Question: Generate an informative caption for the figure above.
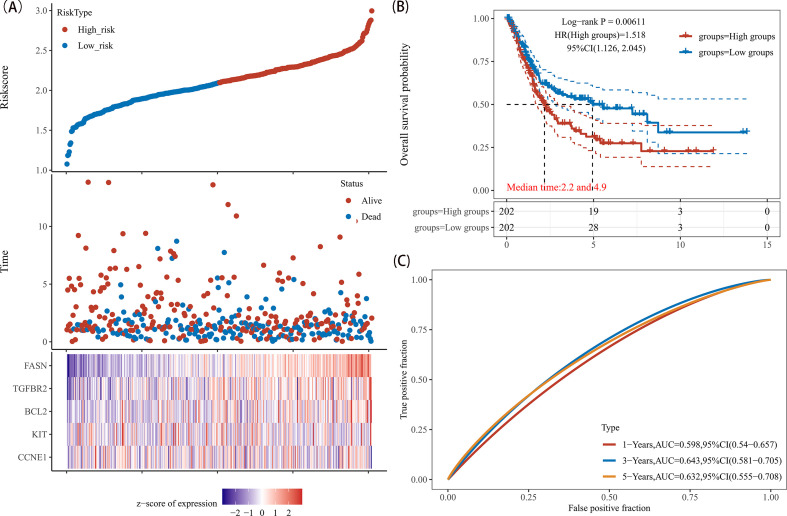
Answer: Prognostic model of BCa. (A) Distribution of patient risk scores (top), patient survival status and follow−up time (middle), and z−score–normalized expression heatmap of the five signature genes (bottom). (B) Kaplan–Meier overall survival curves for high−risk (red) versus low−risk (blue) groups. (C) Time−dependent receiver operating characteristic (ROC) curves for the risk model at 1, 3 and 5 years.